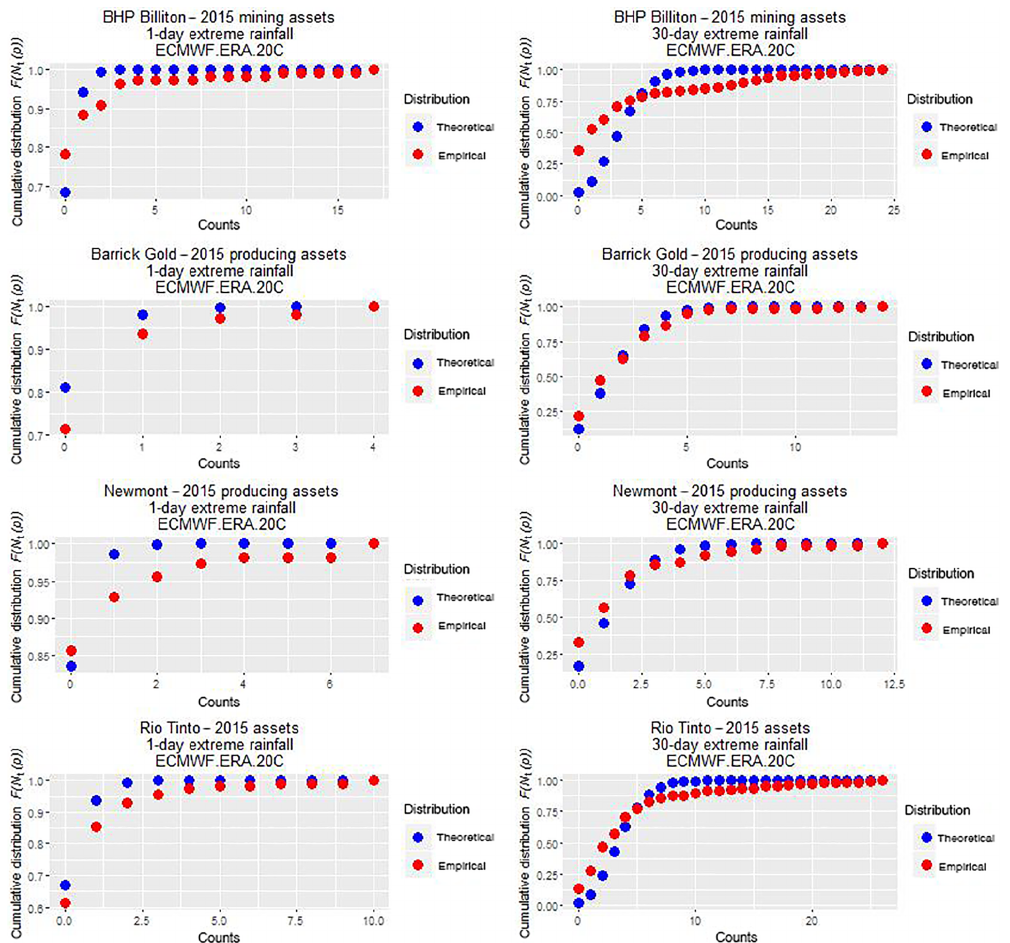
Figure C2. Comparison of the cdf’s of the yearly number of 1-day (left panels) and 30-day (right panels) extreme rainfall events hitting the BHP, Barrick Gold, Newmont and Rio Tinto mine portfolios with the corresponding theoretical cdf’s assuming independence of events in space and time (Poisson processes). Empirical distributions were derived from the N t (p) time series using the ecdf R function, which computes an empirical cumulative distribution function. The ERA-20C dataset was